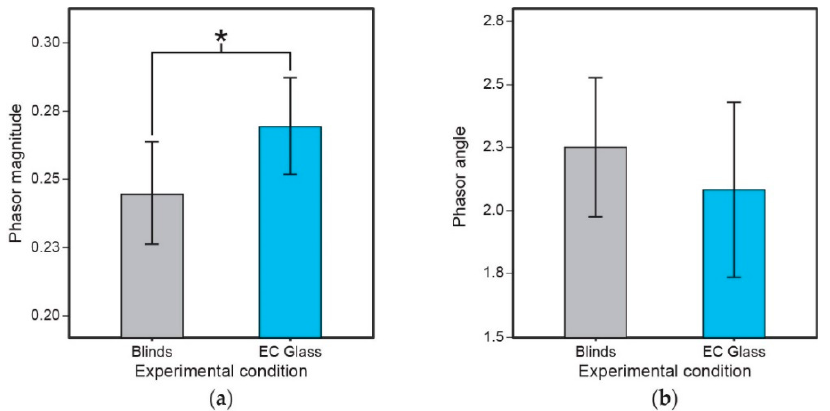
Figure 5. ( a ) Effect of intervention on phasor magnitude and ( b ) phasor angle as calculated from the Daysimeter data for 15 participants. The error bars represent standard error of the mean. (Statistical significance: * represents p ≤ 0.)